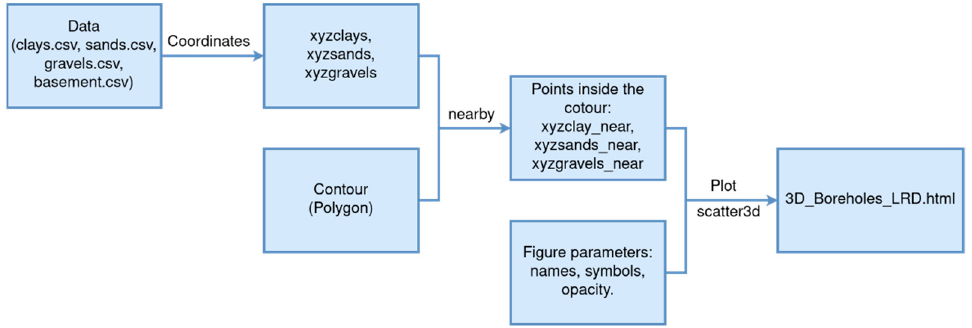
Figure 5. Flow diagram showing the 3D borehole granulometry mapping stage.